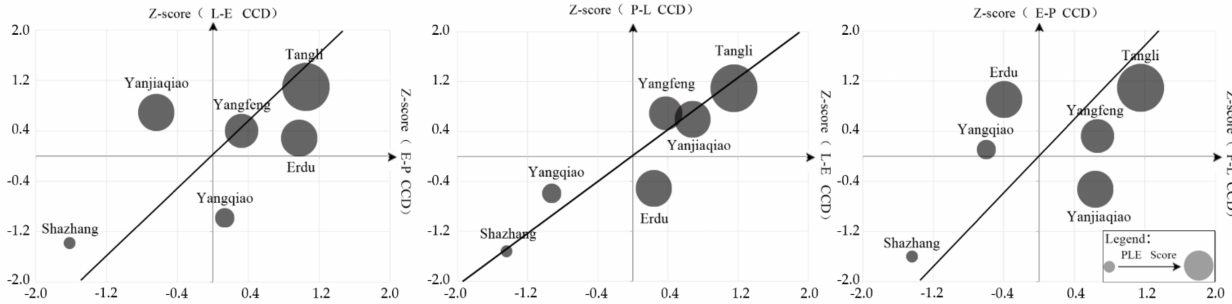
Figure 6. The relationship among pairwise mutual